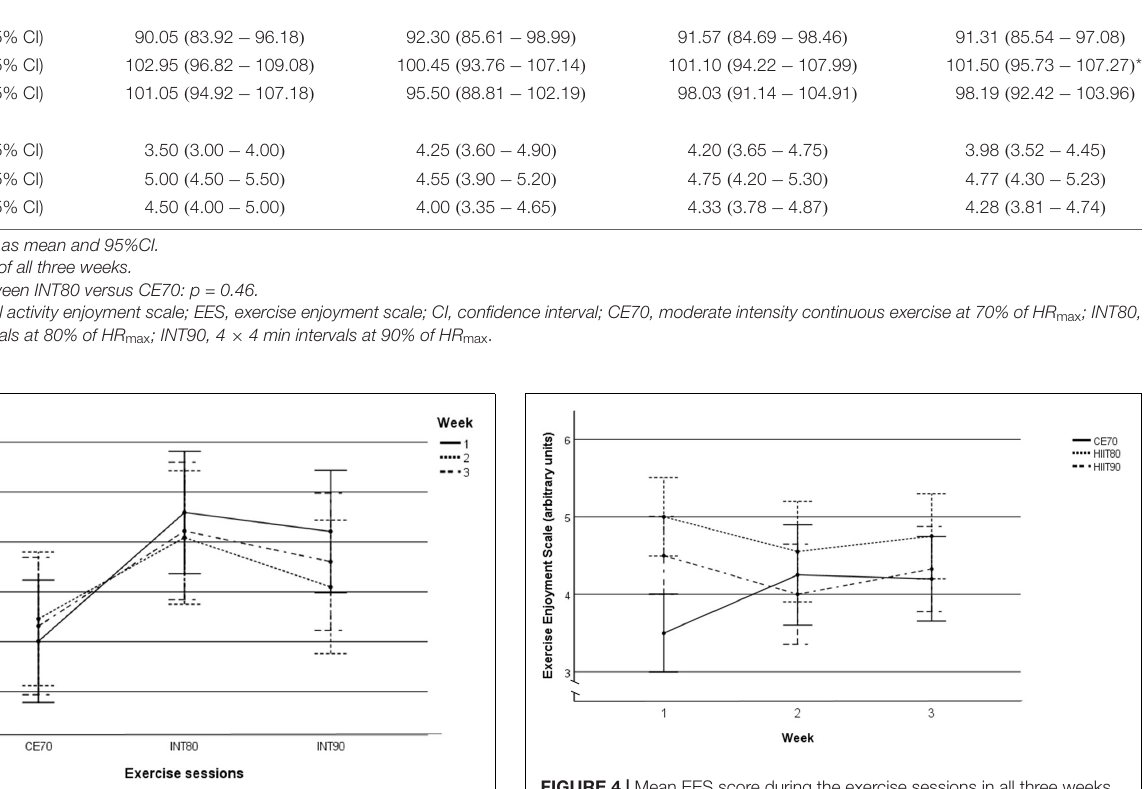
FIGURE 3 | Mean PACES scores after the exercise sessions in all three weeks separately. Between subject effects: p = 0.046, p η 2 : 0.10. Post hoc comparisons: INT90 vs. IN80: p = 1.00, INT90 vs. CE70: p = 0.29, INT80 vs. CE70: p = 0.046. Data are shown as mean and 95% CI. PACES, Physical Activity Enjoyment Scale; INT90, interval exercise session at > 90% of HR max . INT80, interval exercise session at > 80% of HR max ; CE70, continuous